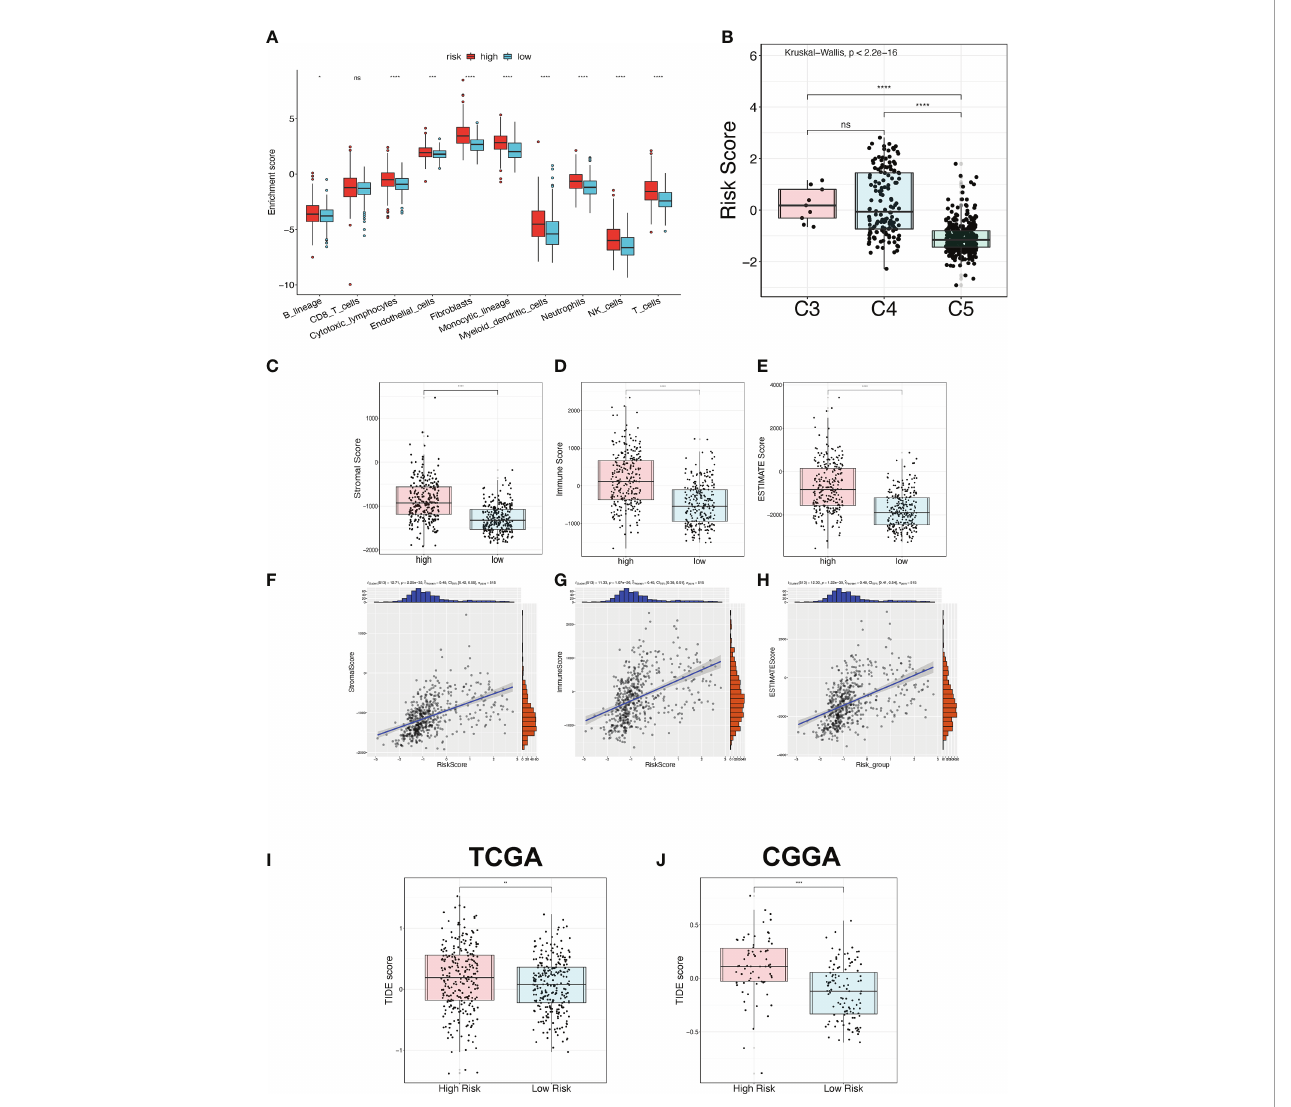
FIGURE 6 TME and immunotherapy prediction analysis. (A) The immune cell in fi ltration status between the high-risk and low-risk groups in the TCGA-LGG cohort was estimated via the MPC-counter algorithm. (B) The risk score between three immune subtypes. C3: In fl ammatory; C4: moderate lymphocyte depletion; C5: immunologically quiet. (C-E) The ESTIMATE-related score between high-risk and low-risk groups in the TCGA-LGG cohort, including stromal score (C) , immune score (D) , and ESTIMATE score (E) . (F-H) The Pearson correlation analysis between the ESTIMATE-related score and risk score in the TCGA-LGG cohort, including stromal score (F) , immune score (G) , and ESTIMATE score (H) . (I, J) The TIDE score for predicting immunotherapy ef fi cacy between the high-risk and low-risk groups in the TCGA-LGG (I) and CGGA325 (J) cohorts. *p<0.05, **p<0.01, ***p<0.001, ****p<0.0001, ns: no signi fi cant